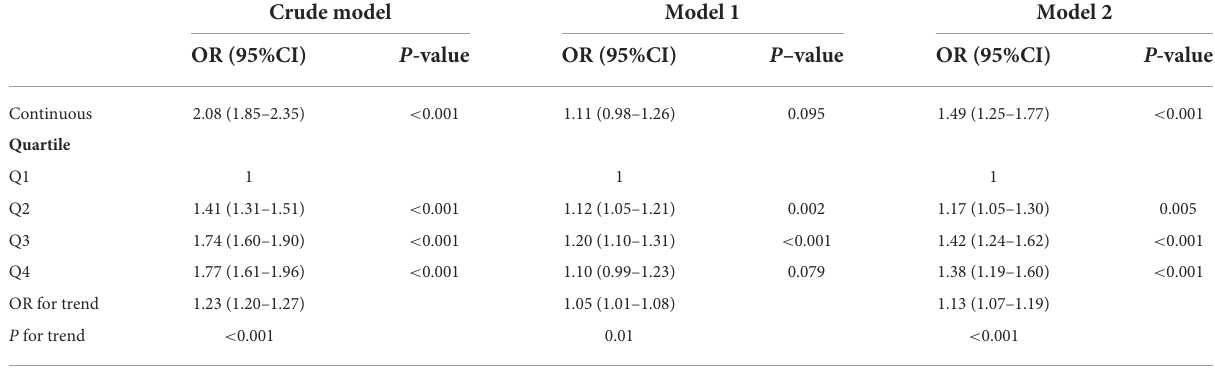
TABLE 4 Association between blood Pb and hyperlipidemia excluding arteriosclerotic cardiovascular disease among US adults in NHANES 1999–2018.